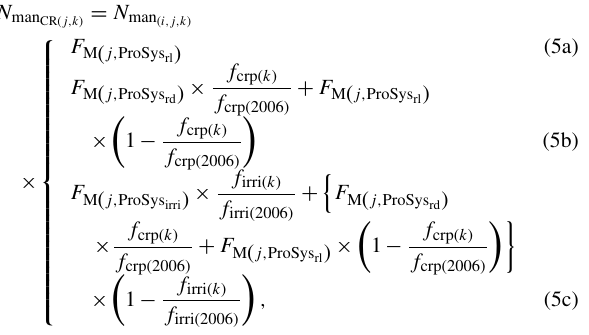
manure management in three livestock production systems, including rangeland-based systems, mixed rainfed farming systems, and mixed irrigated farming systems for cattle (dairy and other cattle), goats and sheep, and smallholder and industrial systems for poultry and swine (Herrero et